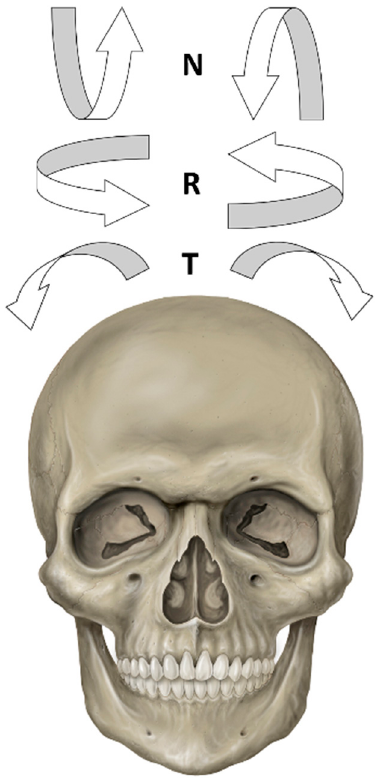
Figure 1. Types of movement of patient’s head. N: nodding. R: rolling. T: tilting.